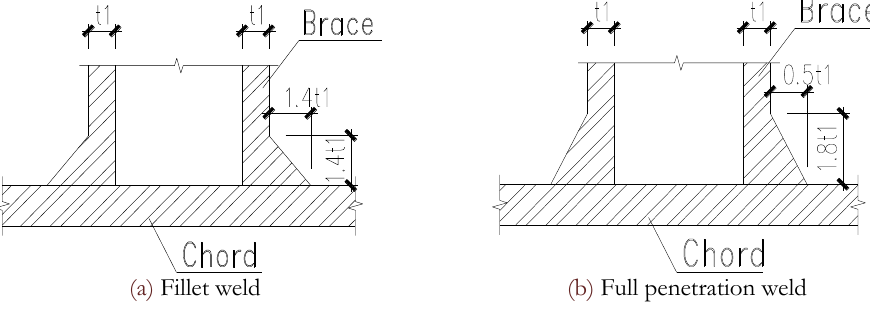
Figure 1: Finite-element model of